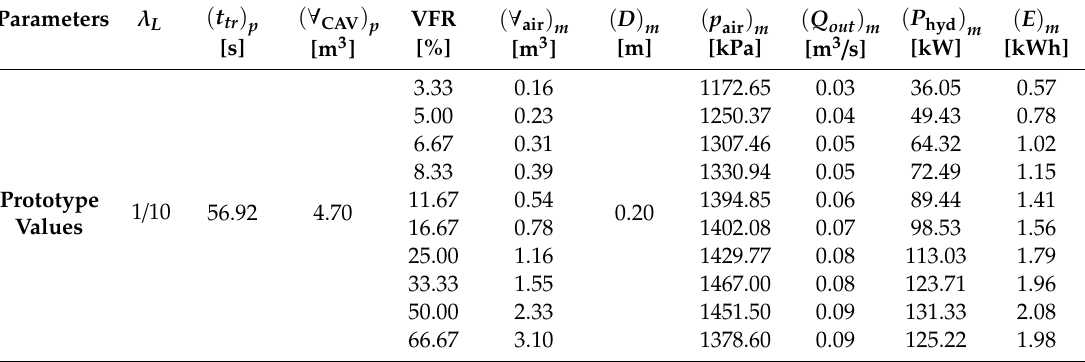
Table 4. Scaled-up parameters for a prototype with length-scale 1 / 10 and di ff erent VFRs. Parameters